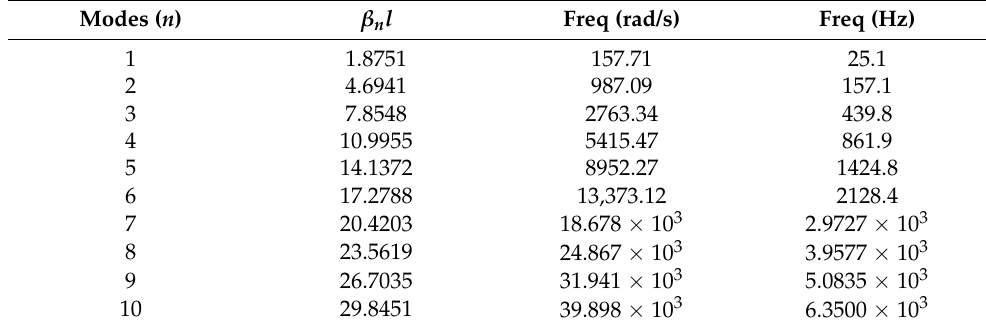
Figure 6. Theoretical mode shapes for first six natural frequencies of a beam. Table 3. Numerical results using MATLAB.